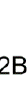
Figure 1. Chemical structures of diquat dibromide (DQ).